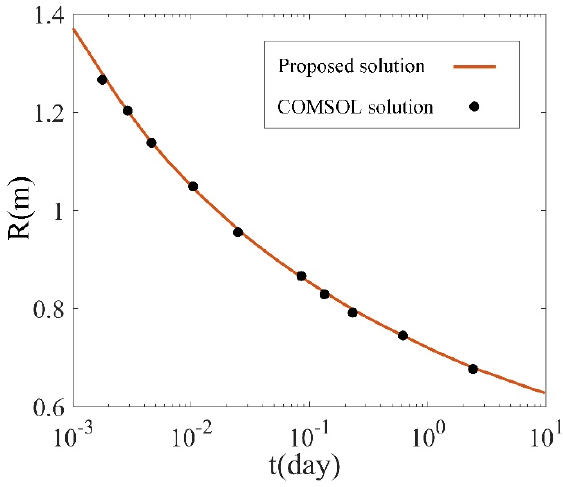
Figure 3. Comparison of the interface distance − time curve of analytical and numerical